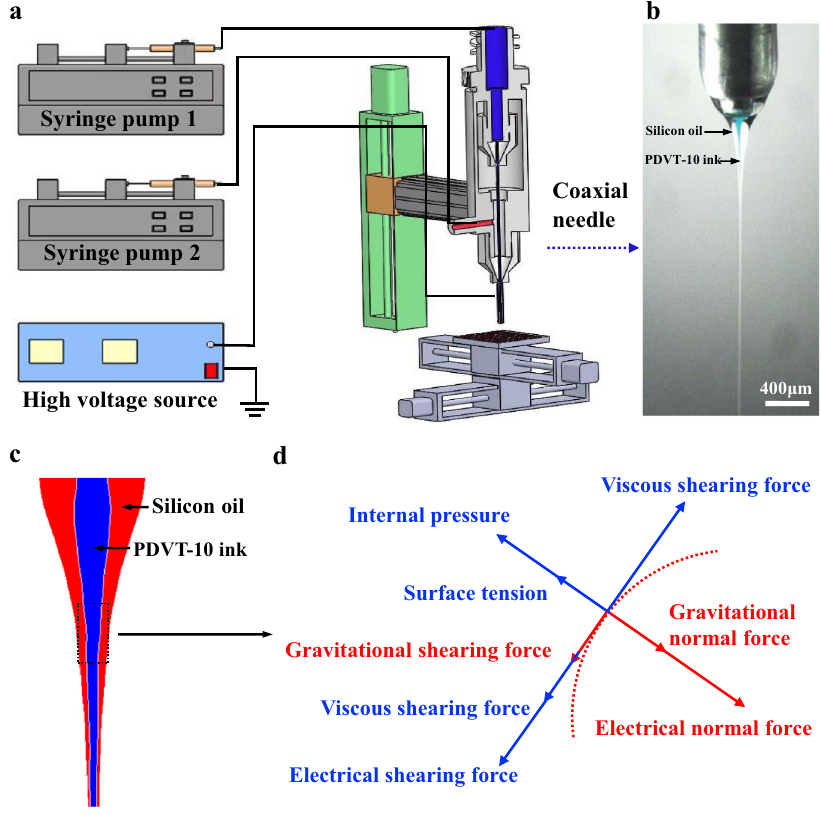
coaxial jet, where the blue part is the internal PDVT-10 ink and the red part is the external silicon